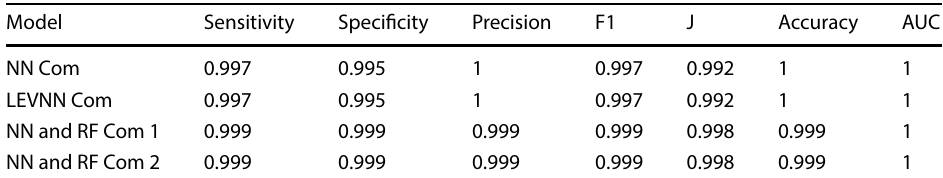
Table 10 Combined classifiers (training)